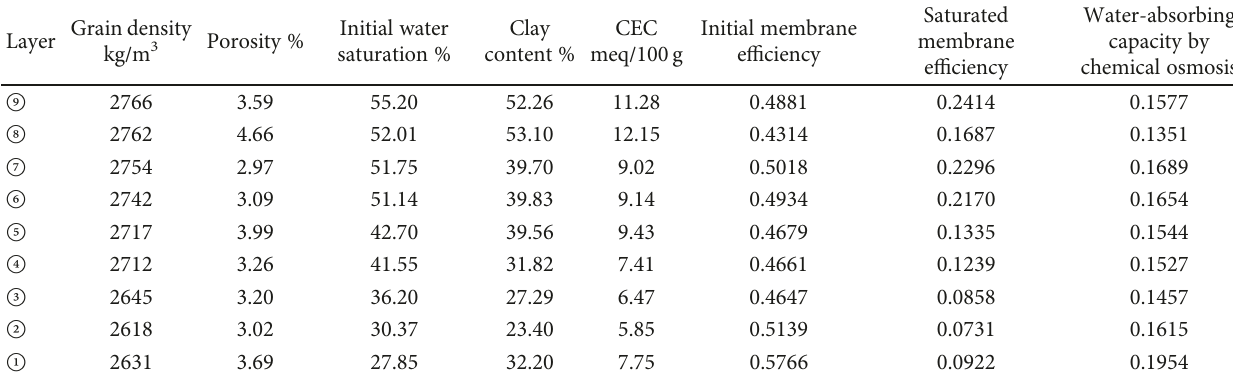
Figure 10: The change in membrane e ffi ciency of reservoir shale throughout the process of water adoption. Table 3: Water-absorbing capacity by chemical osmosis of reservoir